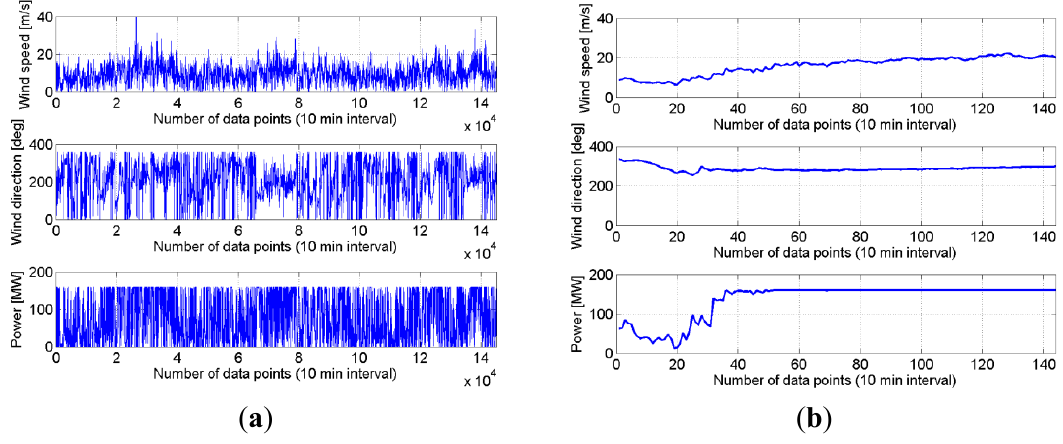
Figure 3. Time series of wind speed, wind direction at hub height and calculated